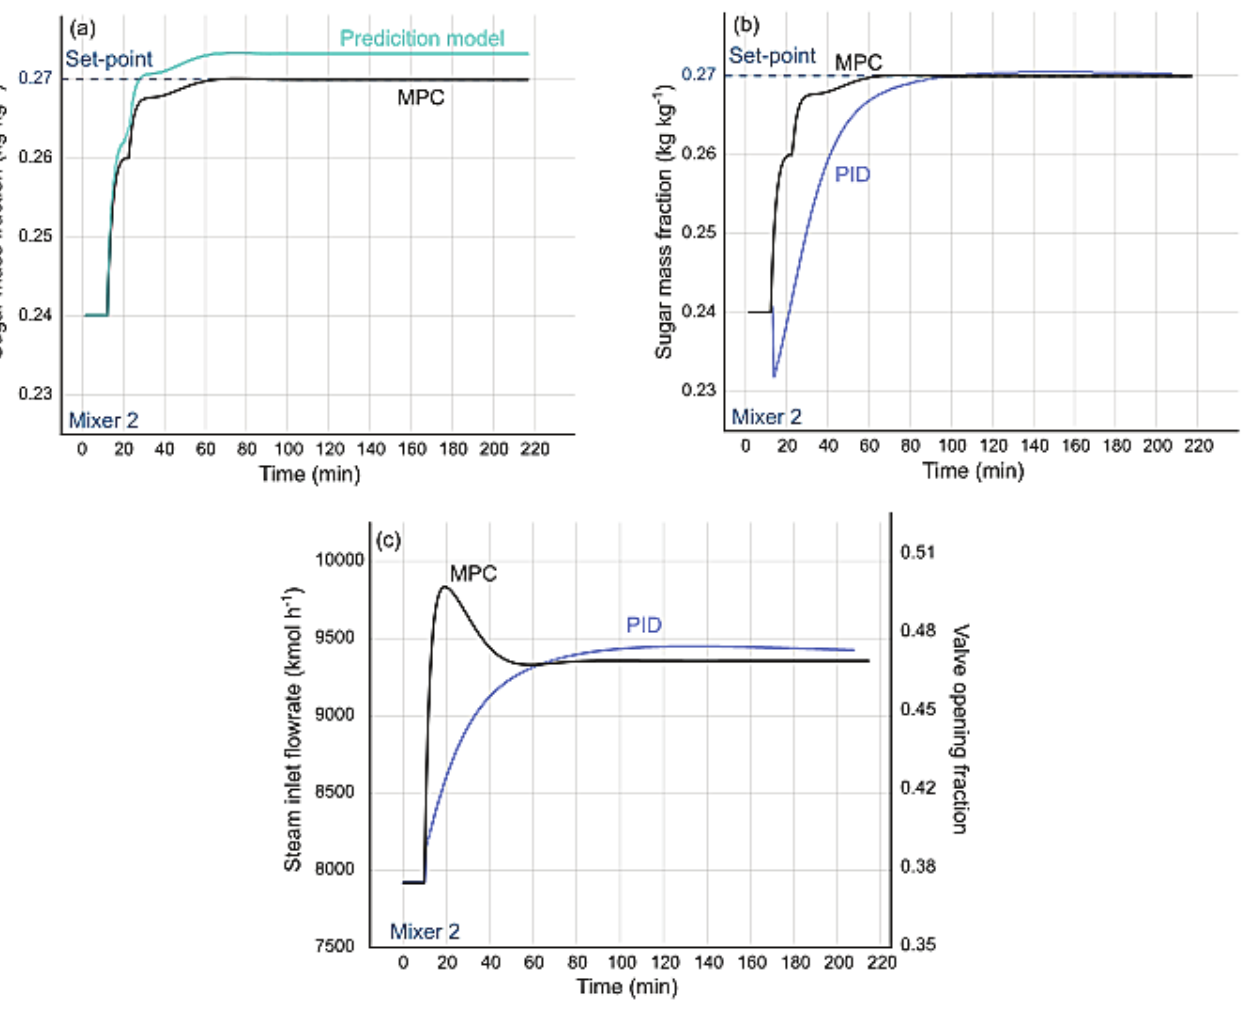
Fig. 5 – MPC response on the plant model (EMSO model) and prediction model (a), comparison of the MPC and the PID perfor- mance (b), and manipulated steam flow rate and valve opening behavior (c) to an increase of 3.0 Brix in the